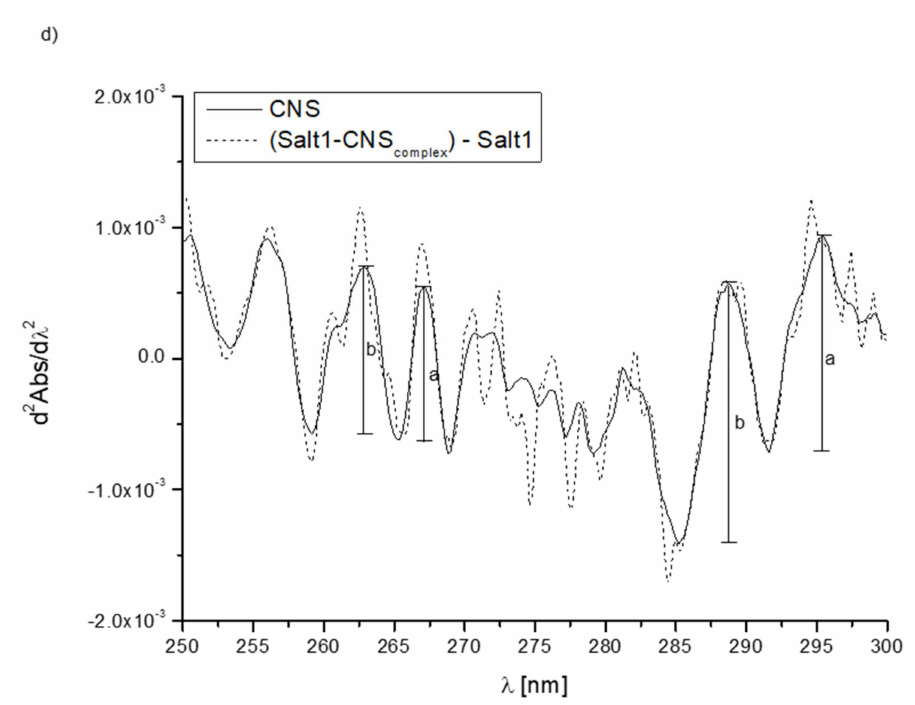
Figure 1. Second derivative absorption spectra of ( a ) HSA (—), ( b ) AGP (—), ( c ) HGG (—) and ( d ) CNS (—) and second derivative differential absorption spectrum of Salt1–protein complex vs. Salt1 (- - - ).